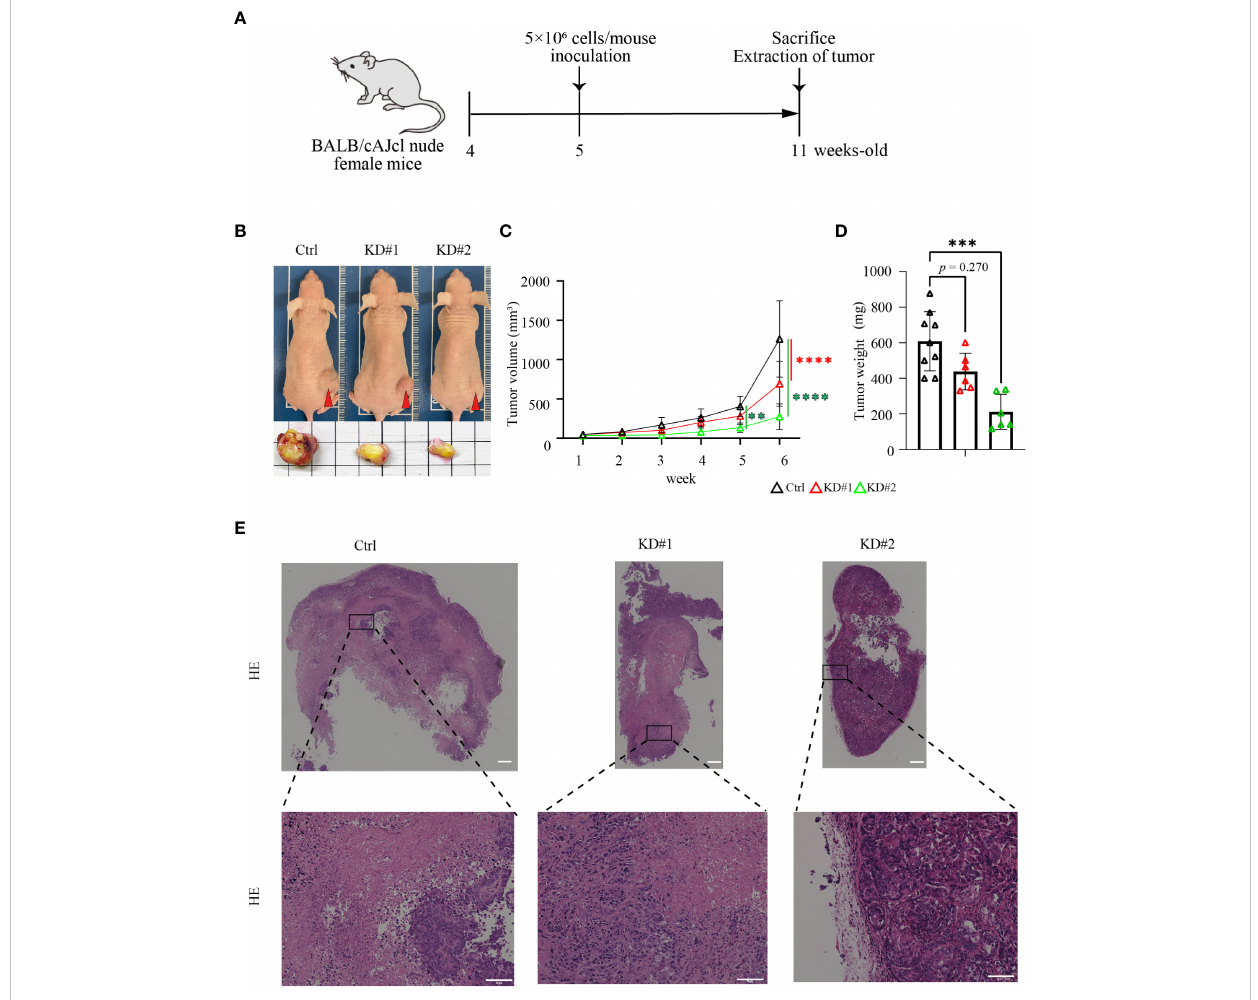
FIGURE 4 LIM1 knockdown suppressed EC tumor growth in vivo . (A) Schematic of the xenograft model experiment. (B) Appearance of representative mice and excised tumors at 6 weeks after inoculation of HEC50B sublines. (C) Changes in the sizes of subcutaneous tumors over time (n = 6 – 9, one-way ANOVA). (D) Comparison of the weights of extracted tumors (n = 6 – 9, one-way ANOVA). ** p < 0.01, *** p < 0.001, **** p < 0.0001. Graphs show means ± standard deviations. (E) HE staining of tumor tissues. Lower panels show high magni fi cation of the boxed areas in upper panels. Scale bar: 50 m